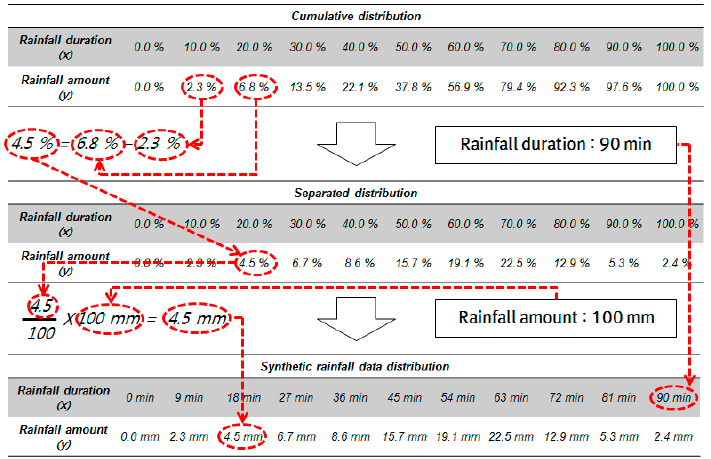
Figure 2. Process for generating the synthetic rainfall data via the Huff distribution (third quartile, 100 mm, 90